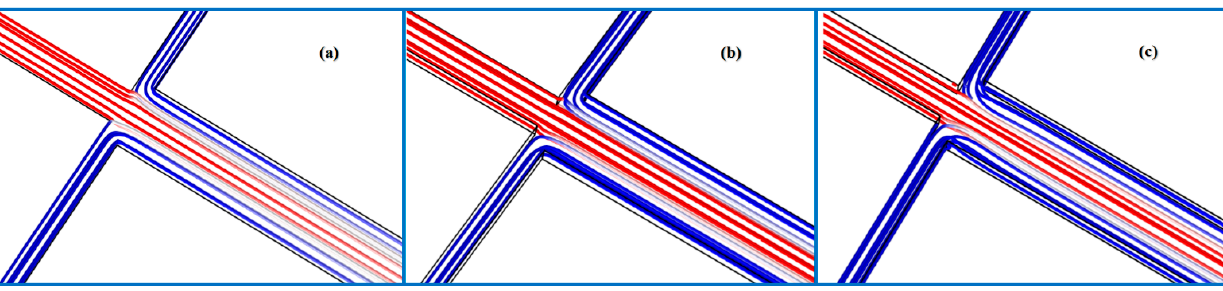
Figure 8. The distributions of streamline at ( a ) Re = 0.1, ( b ) Re = 8 and ( c ) Re = 50.